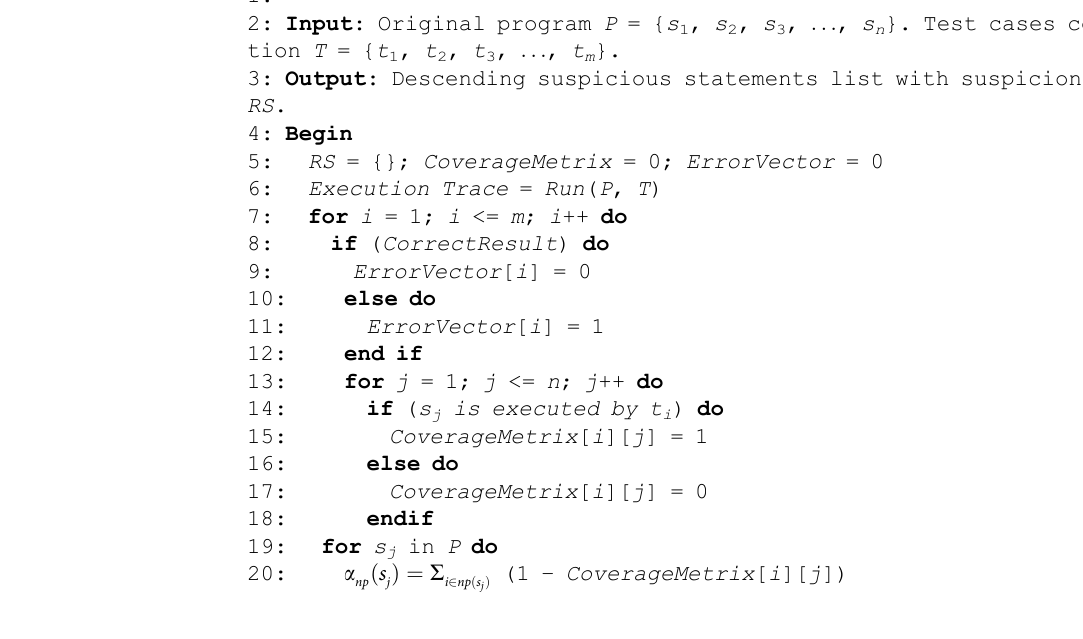
Algorithm 1 SVE Algorithm to